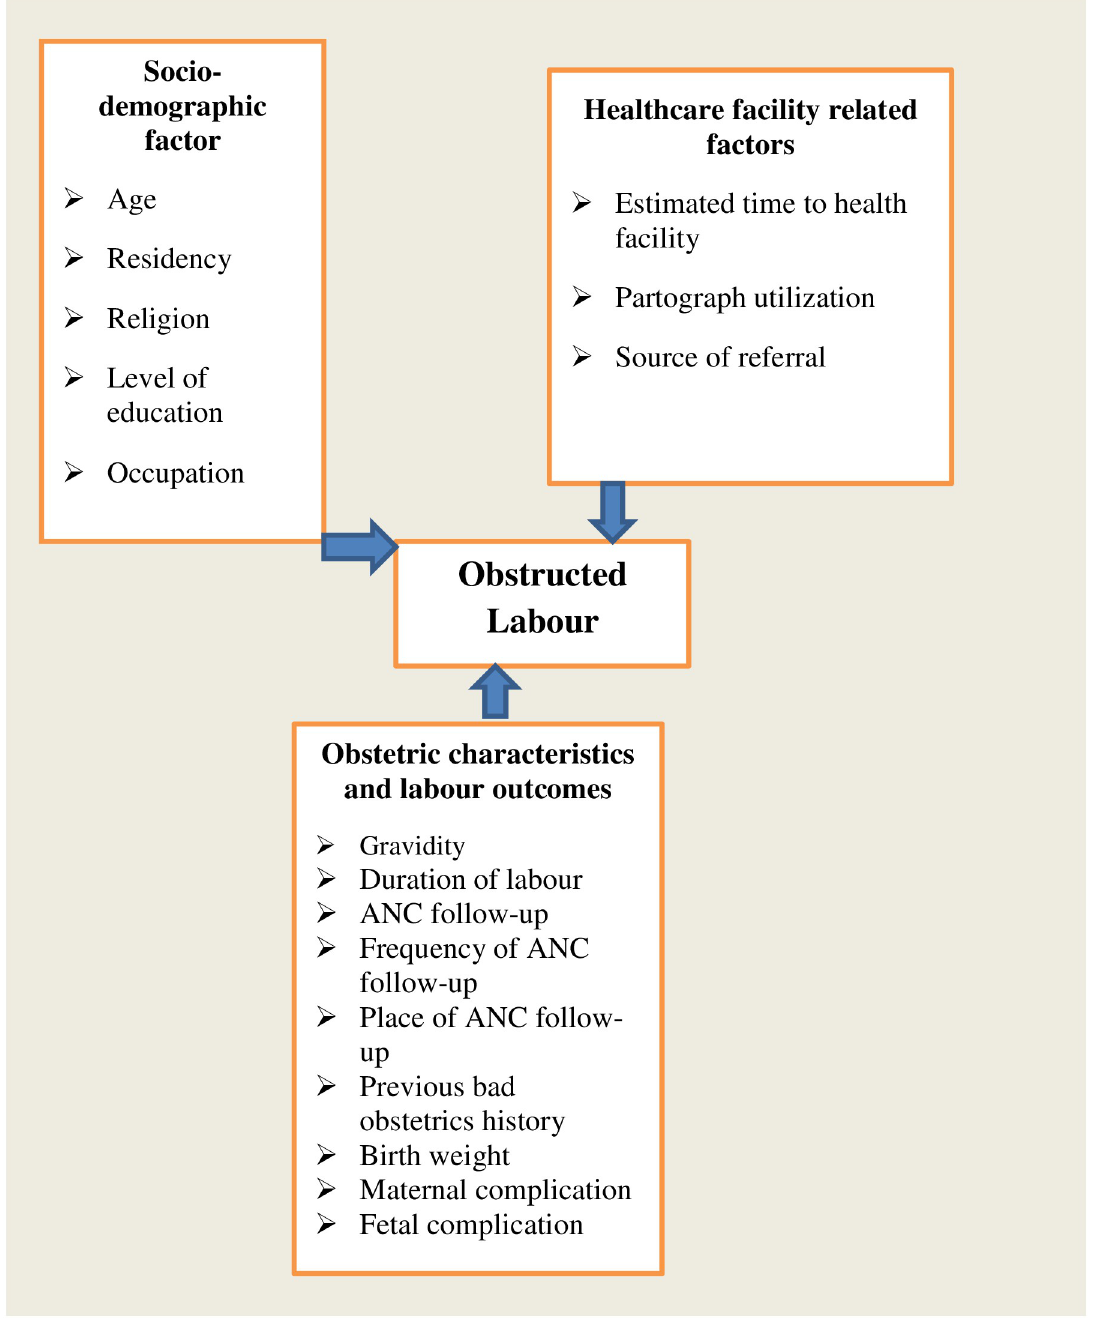
Fig 1. A conceptual framework describing the outcome and explanatory variables of obstructed labour and its associated factors among women who gave birth at public health facilities in Mojo Town, Central Ethiopia,